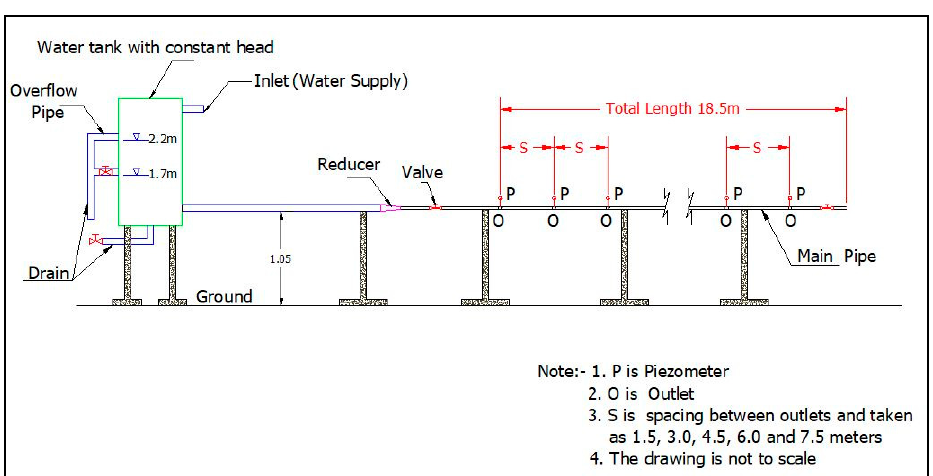
Figure 1. Plan view of the designed physical model.